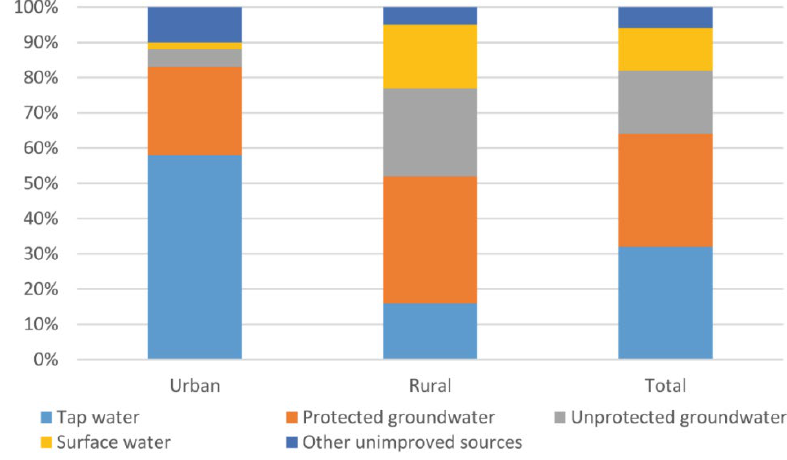
Figure 1. Estimates of sources of drinking water sources in Sub-Saharan Africa [37].